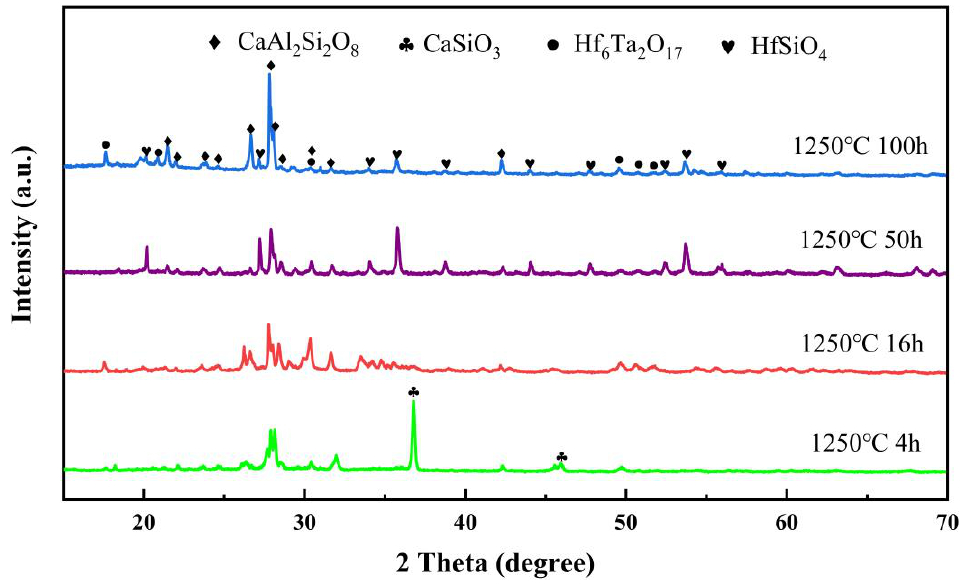
Table 2. Chemical compositions of the marked regions in Figure 6b.